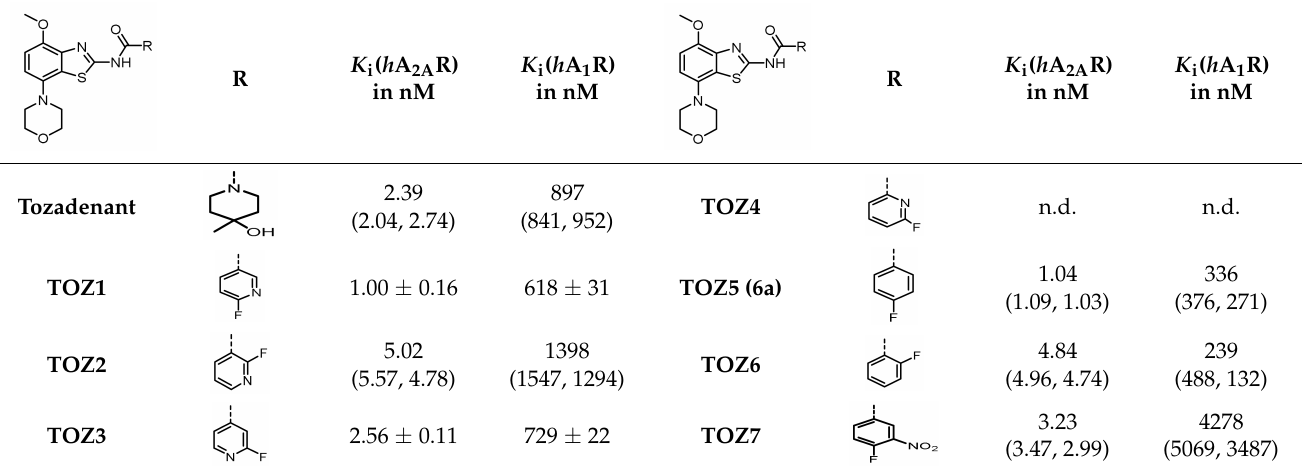
Table 1. Overview of synthesized TOZ derivatives and in-house determined in vitro binding of Figure 2.